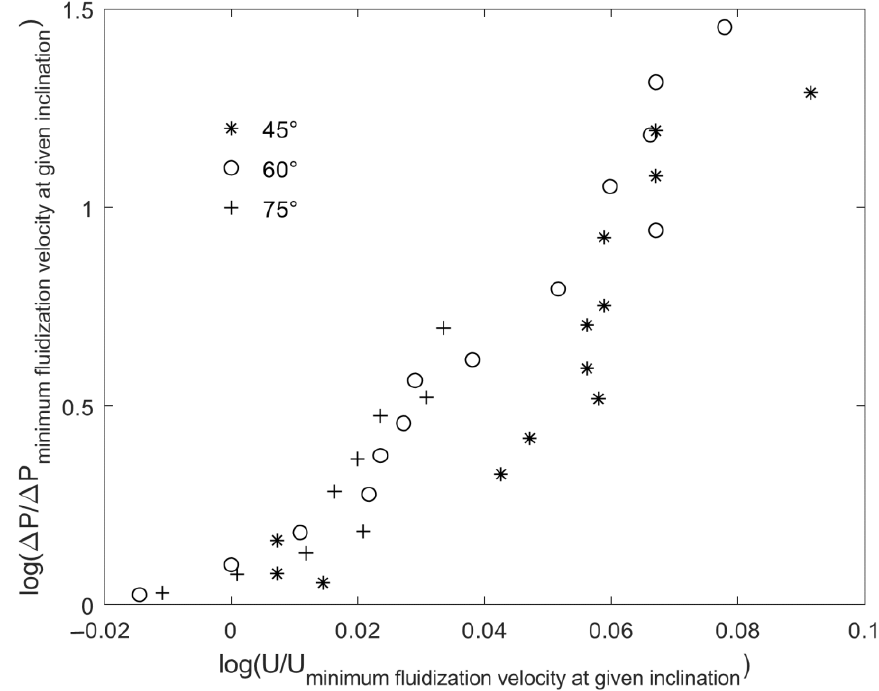
Figure 2. Chong et al. re-plotted as a function of minimum fluidization velocity and pressure drop for each inclination, instead of considering that of a vertical bed as the reference condition.